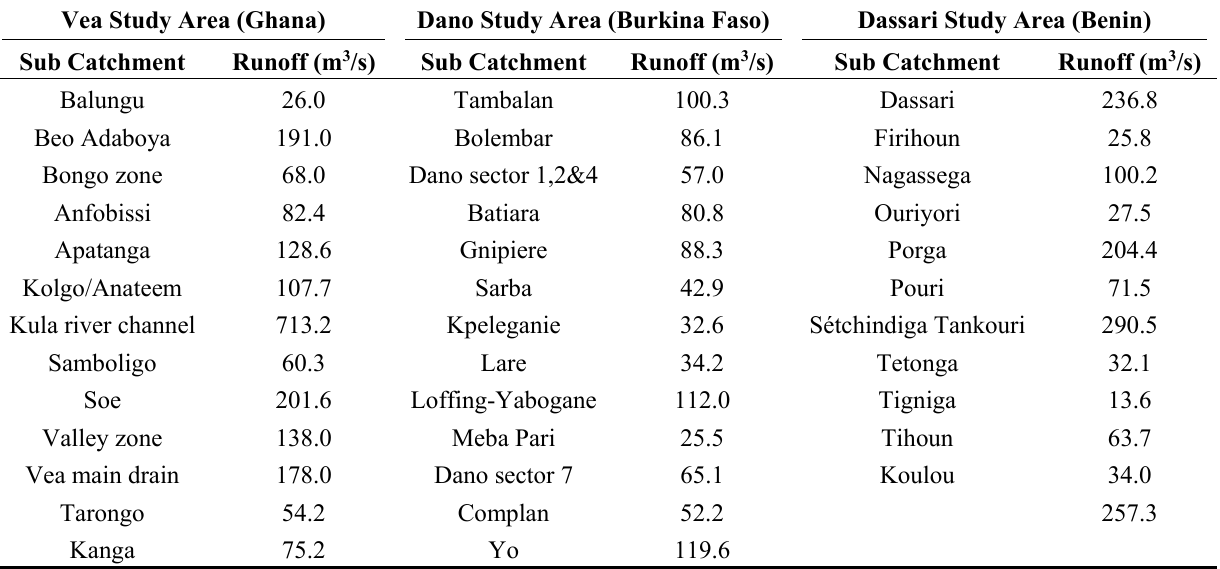
Figure 6. Peak runoff maps of the three study areas. Table 3. Results of total amount of peak-runoff generated within the various sub-catchments. Vea Study Area (Ghana) Dano Study Area (Burkina Faso) Dassari Study Area